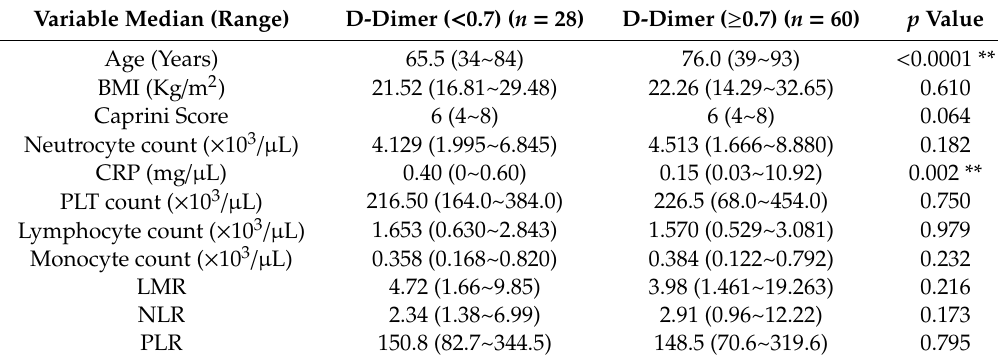
Table 2. Study variables versus